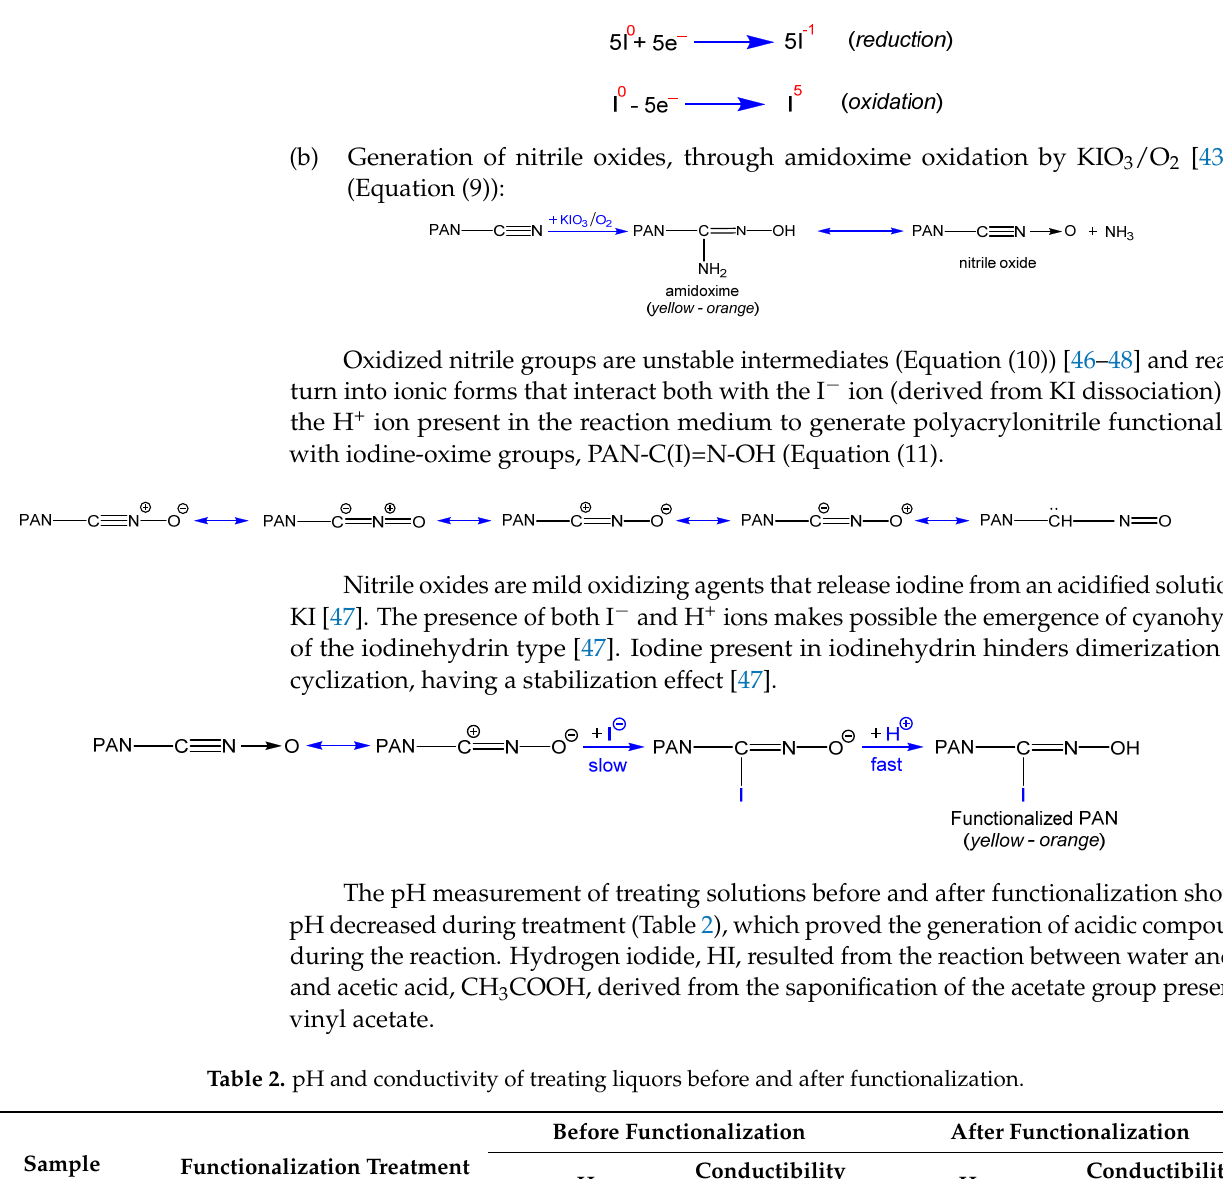
Sample Functionalization